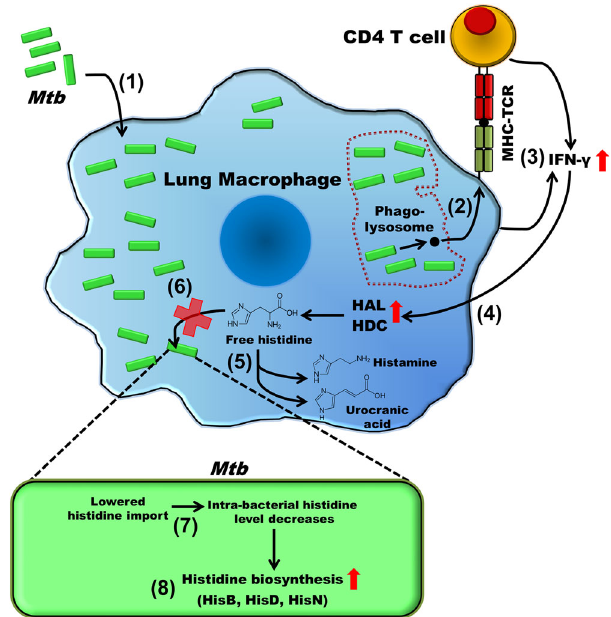
Fig. 7 A schematic representation depicting the CD4 T-cell-directed and IFN- γ -mediated host immune response and the counter response by Mtb